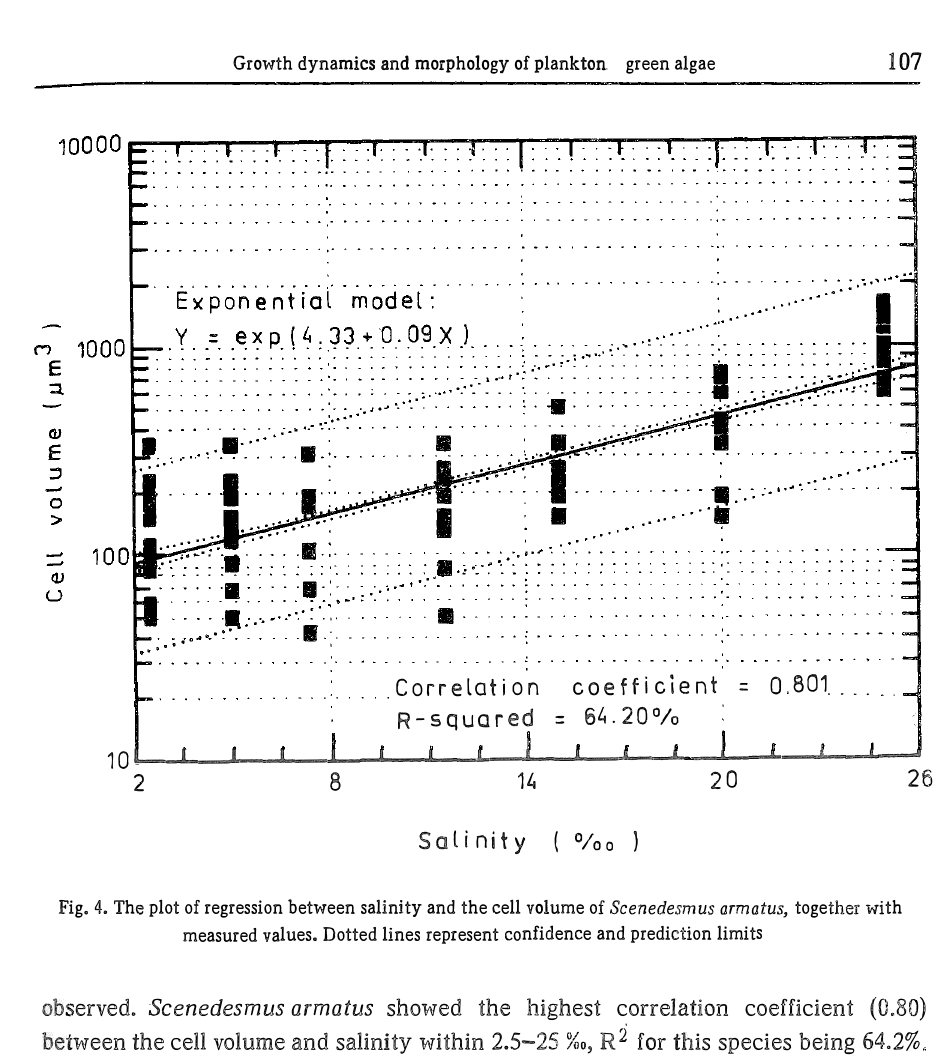
Fig. 4. The plot of regression between salinity and the cell volume of Scenedesmus armatus, together with measured values. Dotted lines represent confidence and prediction